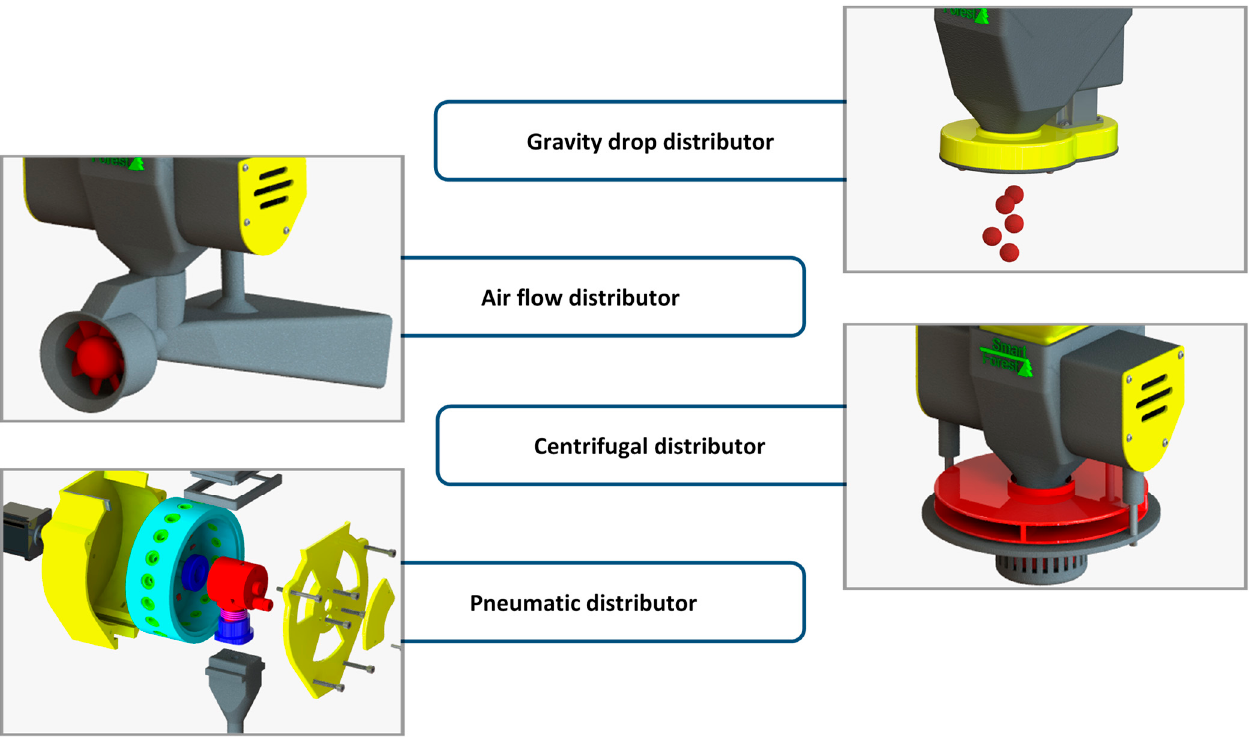
Figure 2. Seed distribution mechanisms.